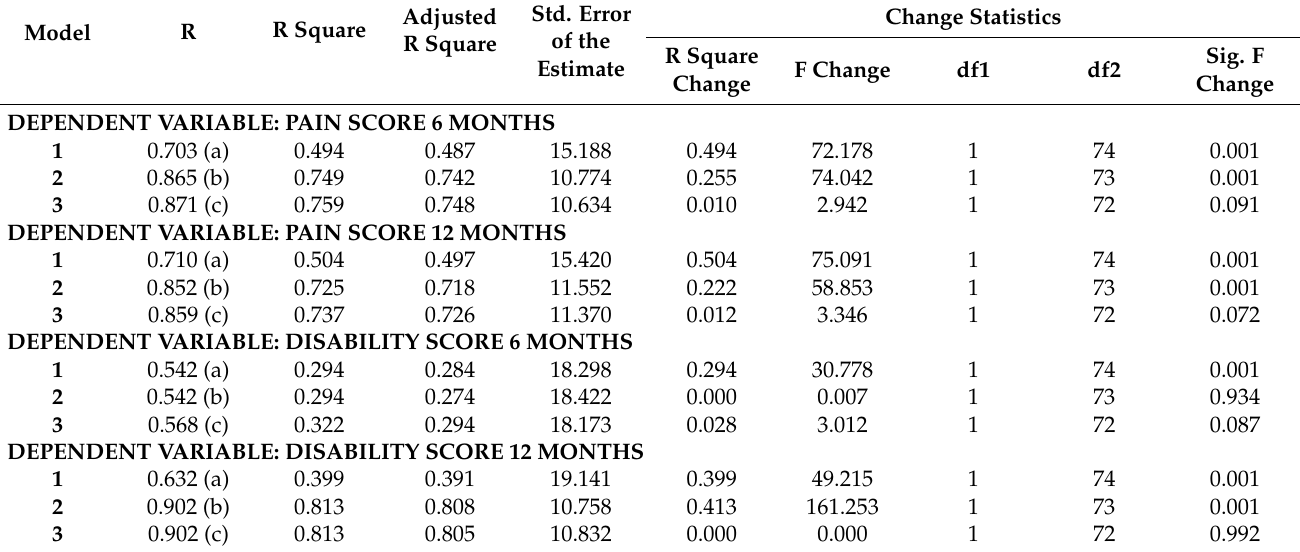
Table 3. Multivariate analysis between gender, initial Von Korff pain and disability scores, and in the Von Korff pain and disability scores at 6 months and at 12